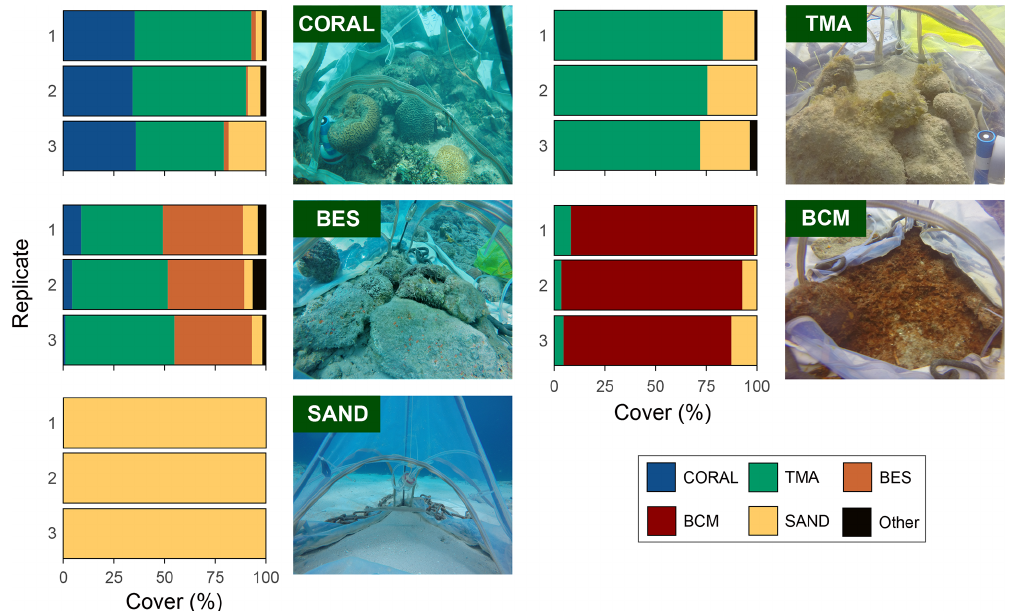
Figure 2. Benthic cover of the 15 incubated reef communities dominated either by coral, turf and macroalgae (TMA), bioeroding sponges (BESs), cyanobacterial mats (BCMs), or sand with exemplary